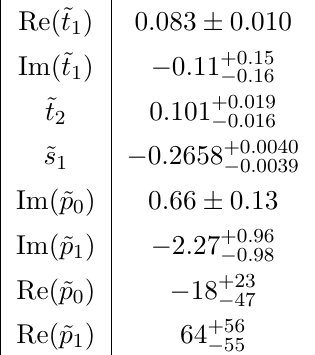
Table 3 . Results for hadronic matrix elements of the U -spin expansion eqs. (3.4)–(3.7), as extracted from the experimental data in tables 1 and